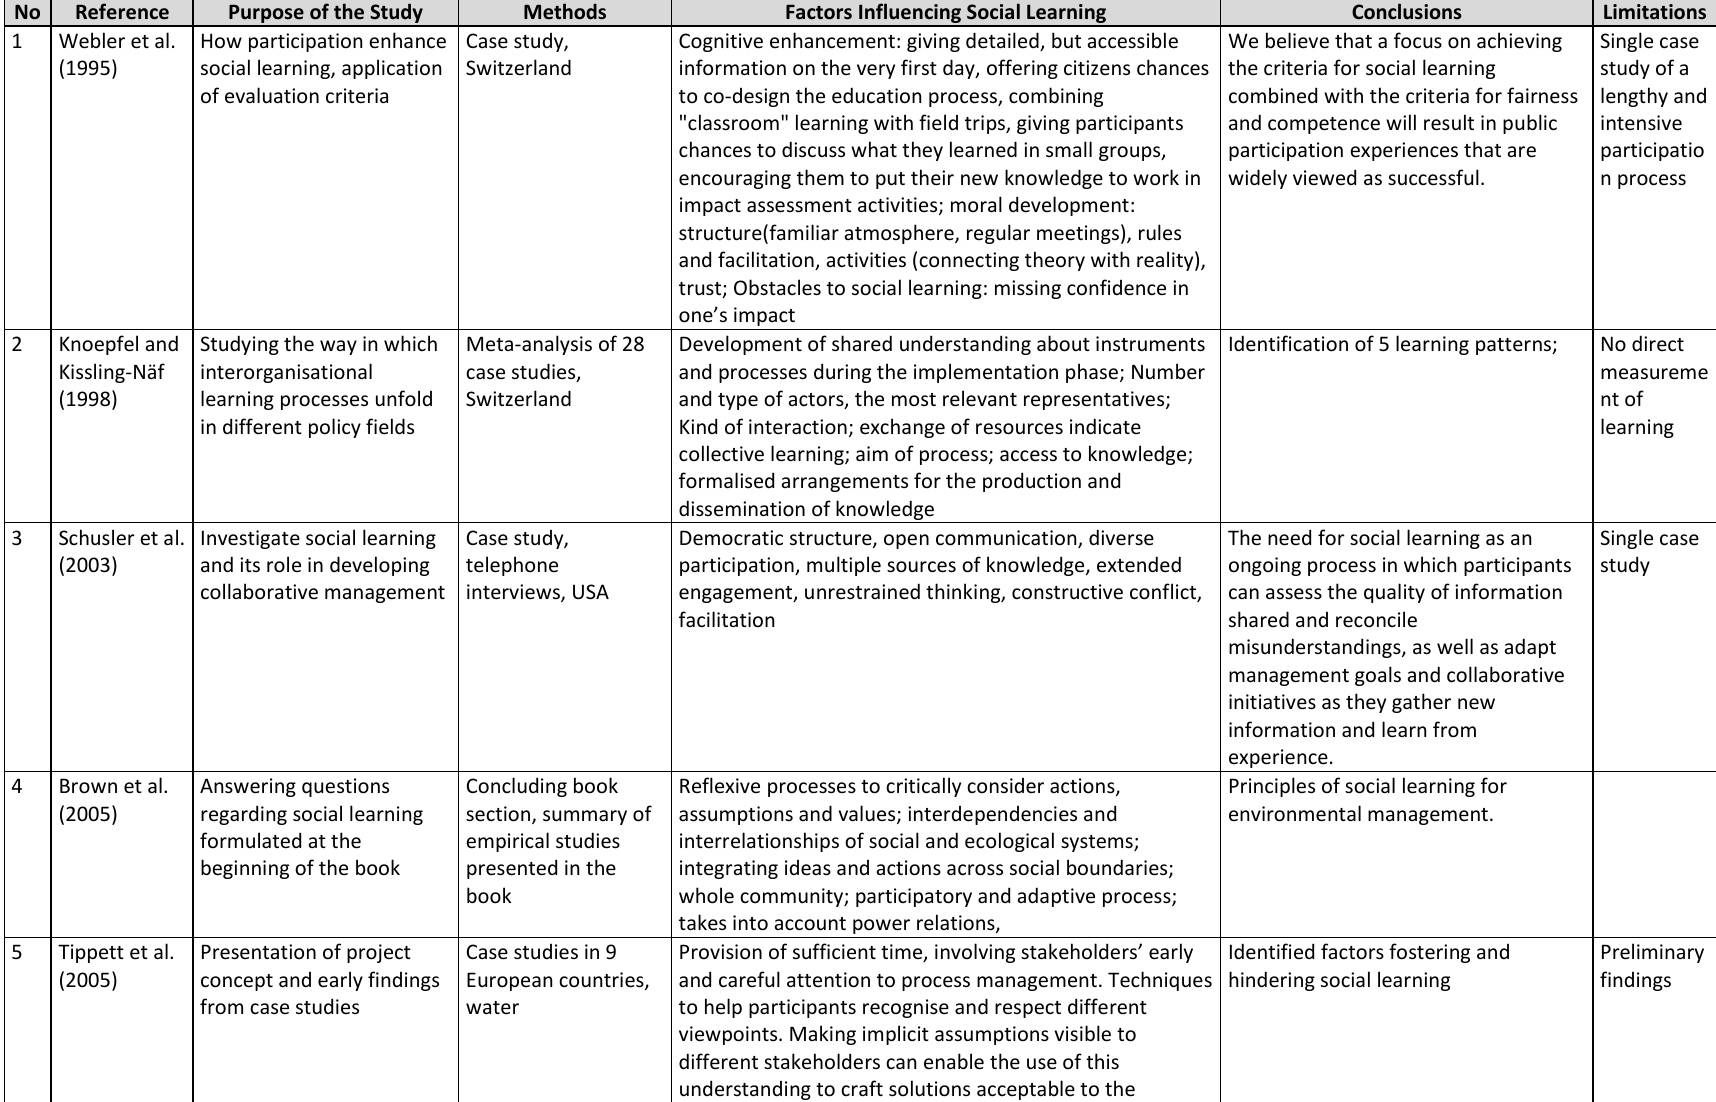
Table 2: Reviewed Literature Assessment of Social learning in Chronical Order